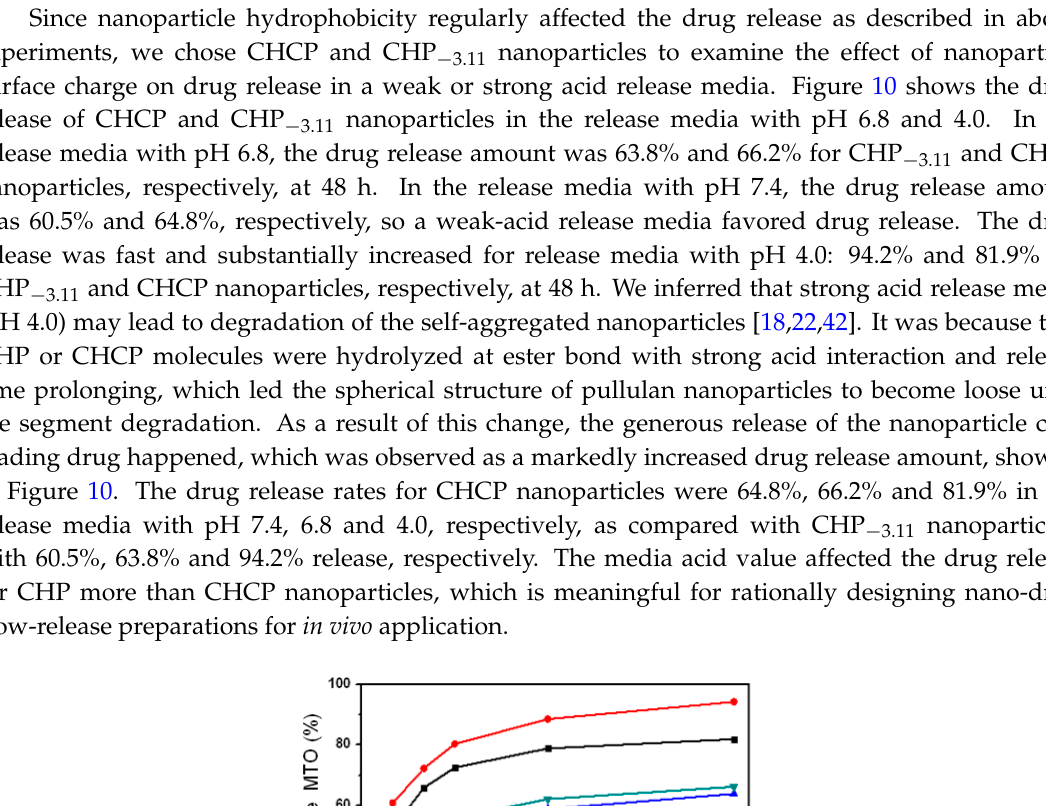
Figure 9. The mitoxantrone (MTO) release of pullulan nanoparticles in phosphate buffered saline (PBS) at 37 °C in vitro ( ■ : free mitoxantrone, ▼ : CHP − 3.11 , ◄ : CHCP, ● : CHP − 6.03 , ▲ : CHP − 6.91 ).